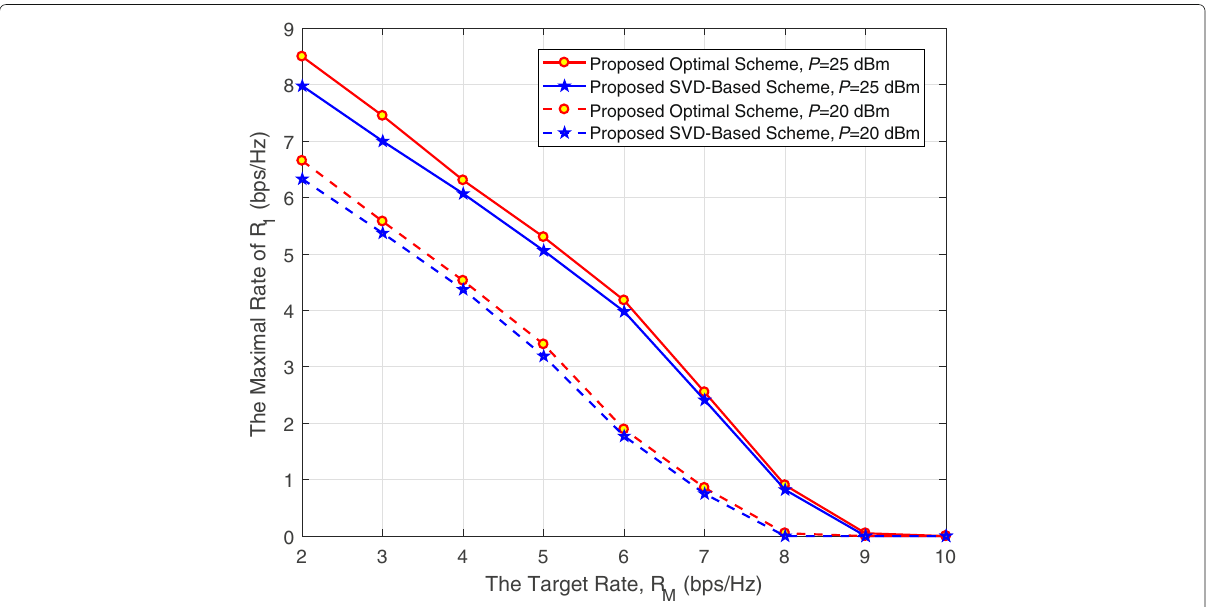
Fig. 4 Simulation 3. The maximal rate of R 1 versus R M for different schemes with N = 4